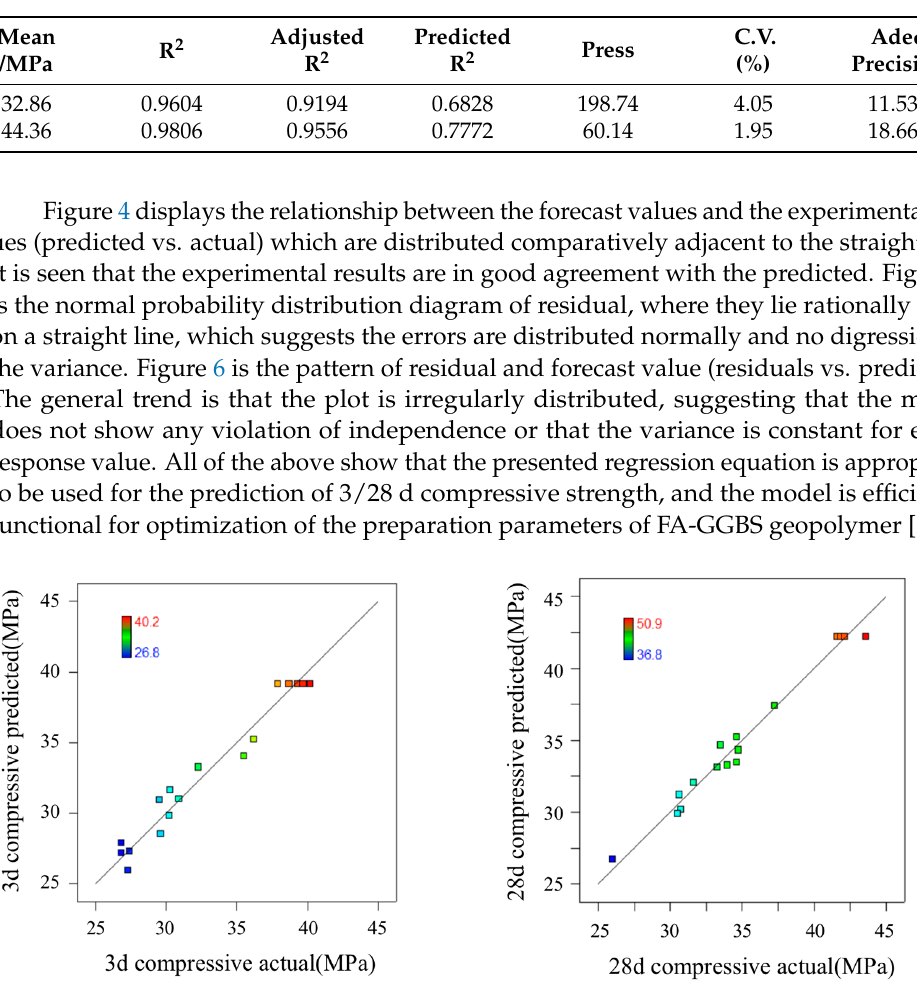
Table 6. Model reliability test analysis.